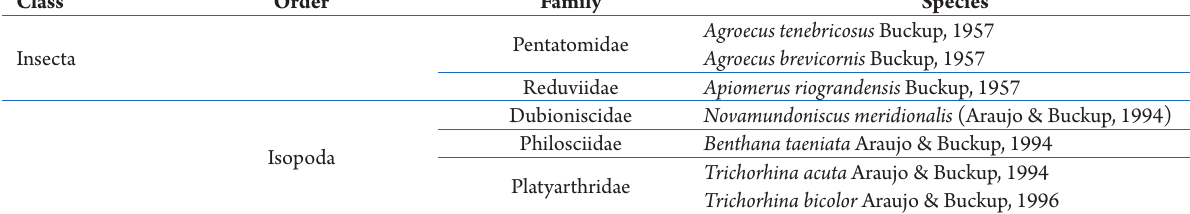
Table 1. New species described by Ludwig